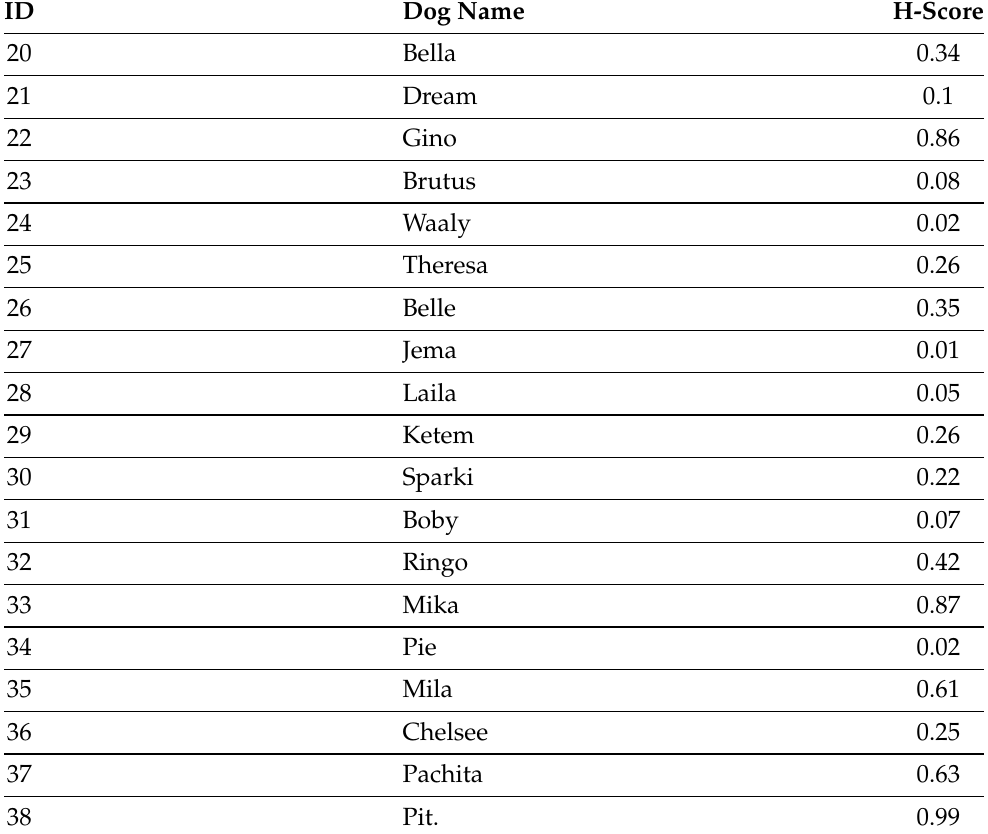
Table 2. H-score of the (single) visit of